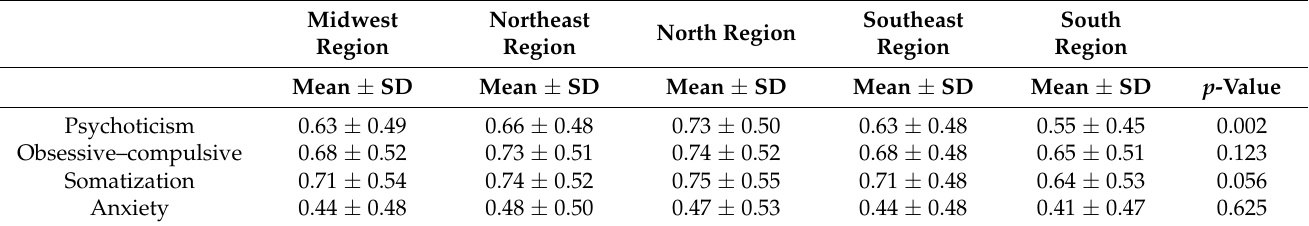
Table 2. Comparison between psychopathological symptoms by regions of Brazil ( n = 1737).